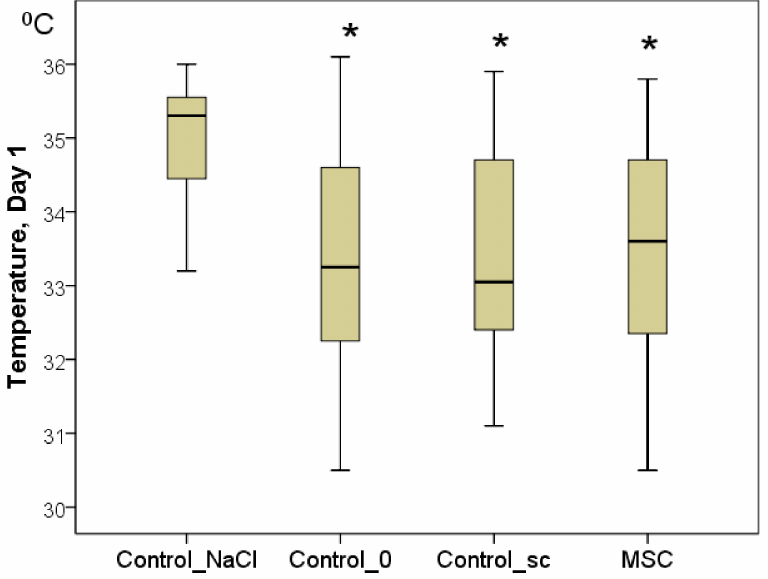
Figure 4. The temperature of the wound centers in different groups on day 1, in degrees Celsius (Kruskal–Wallis test: p = 0.0001; * difference from the Control_NaCl group at p <